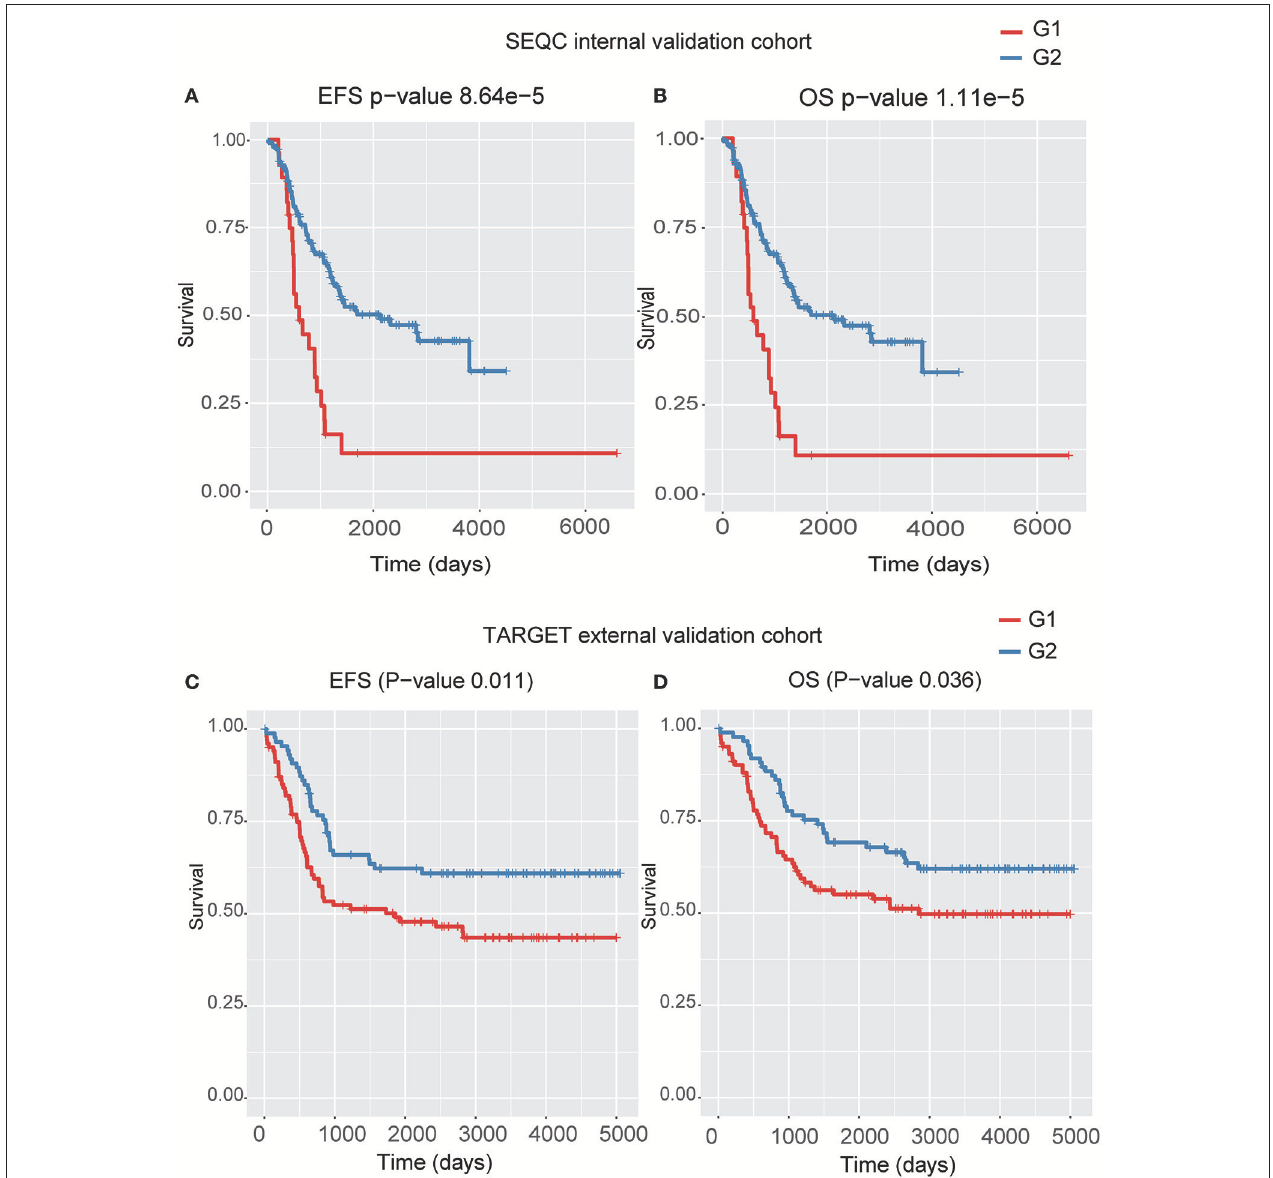
FIGURE 4 | The Kaplan–Meier curves for EFS or OS of two predicted subtypes for the high-risk tumors from SEQC external validation cohort (A,B) and TARGET internal validation (C,D)